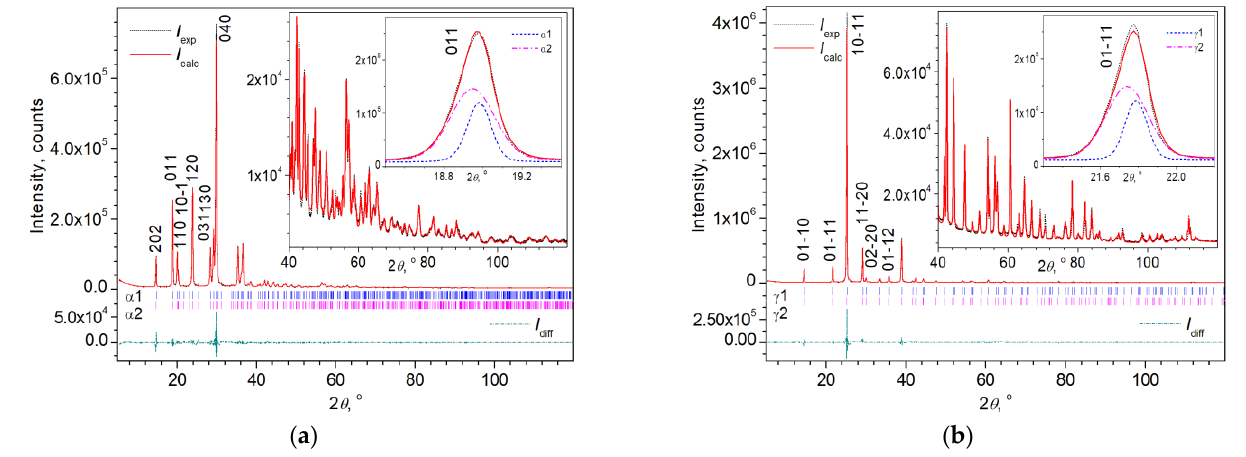
Figure 3. Rietveld fit results for ( a ) α -Gly:CA (90:10) and ( b ) γ -Gly:CA (80:20). During the Rietveld fit the atomic coordinates of the phases were fixed to values determined in single-crystal investigation of this work and not refined. The Miller indices hkl and Miller–Bravais indices hkil of some selected reflections are indicated in ( a ) and ( b ), respectively. Large insets in ( a , b ) portray the quality of fitting the high 2 θ angle regions of the XRD patterns in a larger scale. Small insets present examples of Rietveld fitting the asymmetric non-overlapping reflections.